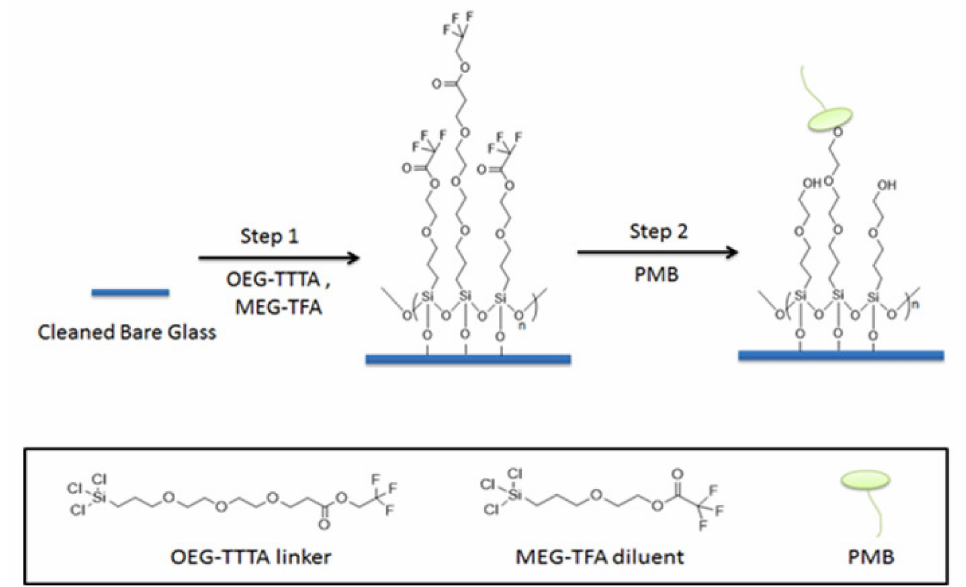
Figure 2. Preparation and immobilization of PMB on bare glass beads. In order to quantify the presence of free LPS and LPS that potentially binds to PMB-modified glass beads, GC-MS was employed to analyze derivatized products of 3-hydroxylauric acid and 3-hydroxymyristic acid [44]. These two fatty acids were selected as they are likely to be released by Lipid A of LPS as products of alkaline hydrolysis. The derivatizing agents were chosen for both the production of the intended separation and the ease of quantification of products (Figure 3).